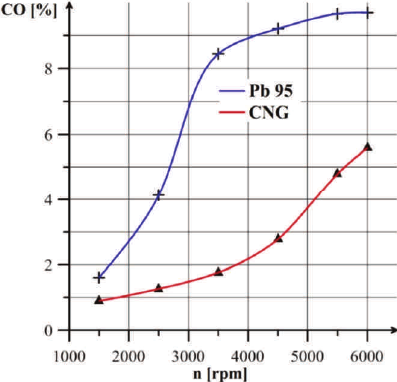
Fig. 7. Concentration of carbon monoxide in the Fiat 0.9 TwinAir engine exhaust gases, working with external speed characteristics and fuelled by petrol Pb 95 and CNG